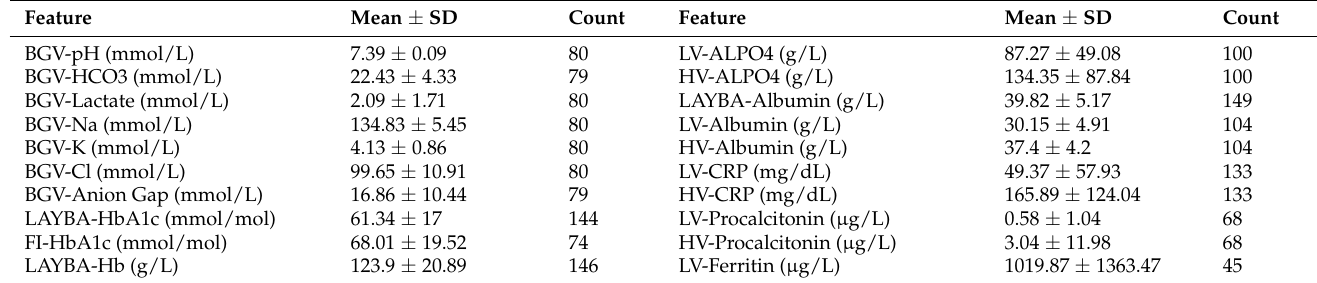
Table 2. A summary of properties of the numerical clinical data used in this article. For each feature, mean and standard deviation, together with the number of patients that a value is recorded for the feature, are